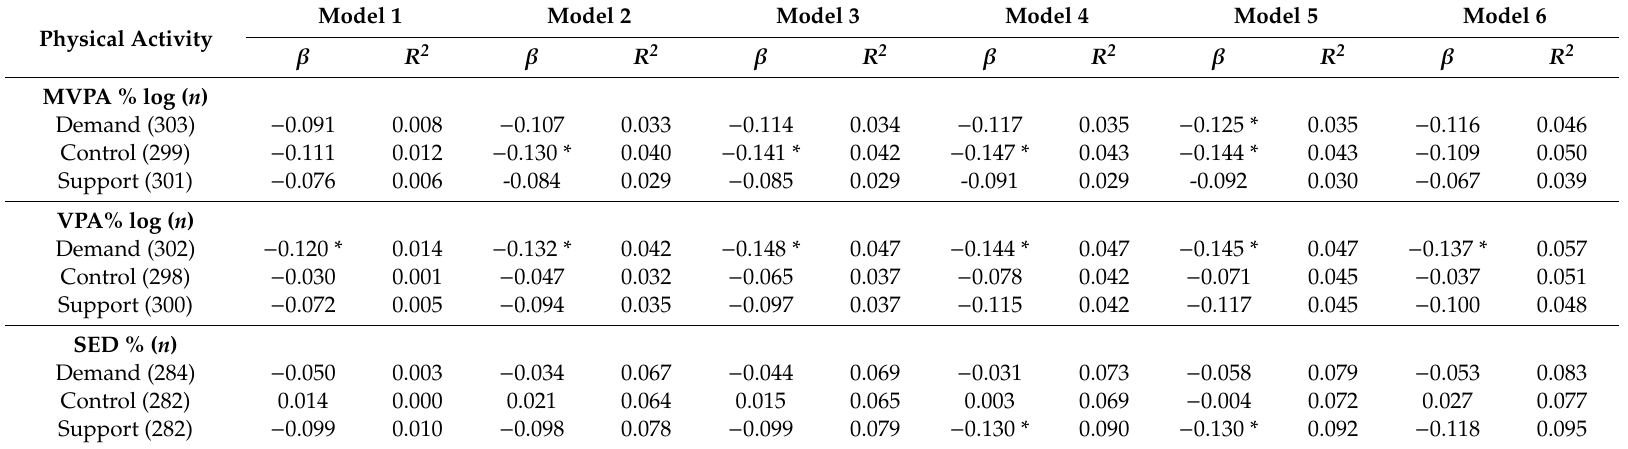
Table 2. Results from the linear regression